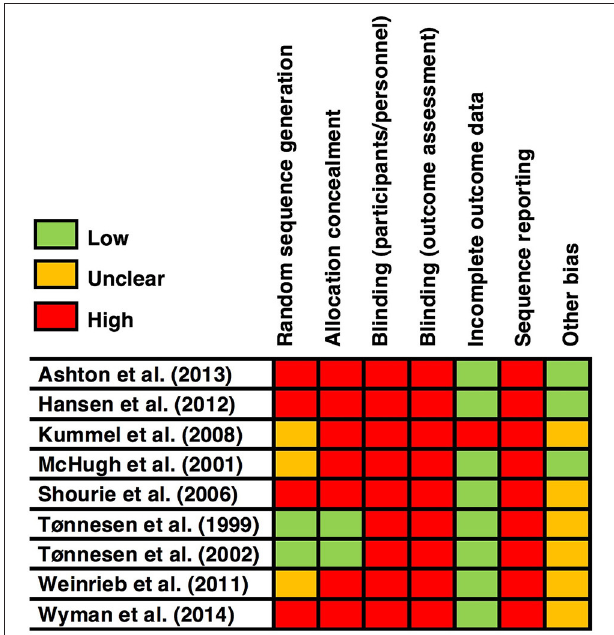
FIGURE 2 | Risk-of-bias across individual